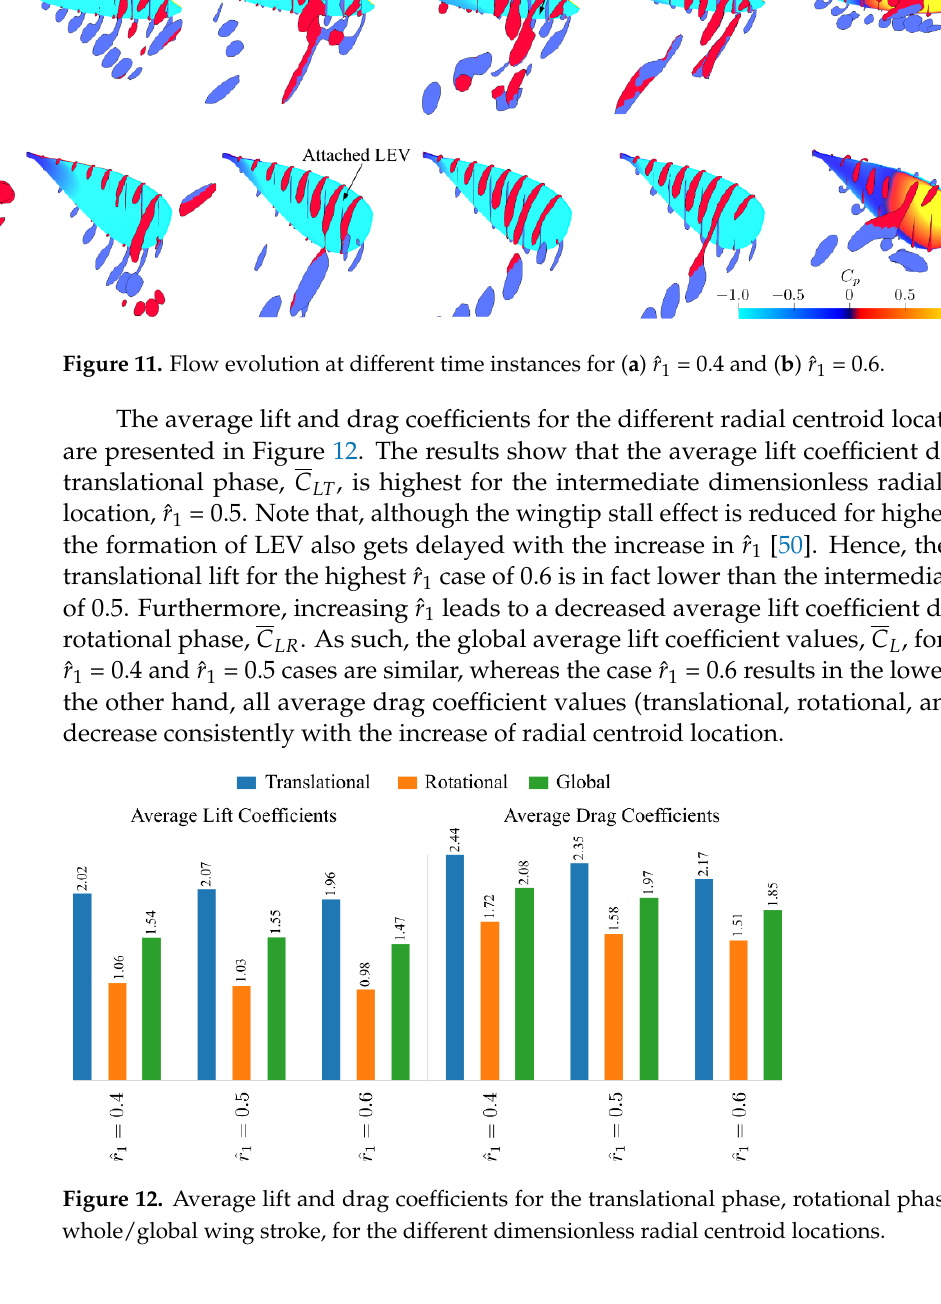
Figure 10. Normal force coefficient distribution along the wingspan for wings with different radial centroid locations. Grey areas represent regions where the normal force coefficient at 𝑡̂ = 4.9 be- comes lower than that at 𝑡̂ = 4.8. Stroke amplitude is fixed to 160° and the aspect ratio is fixed to